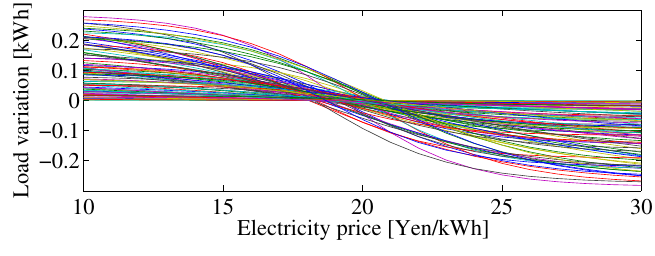
Figure 3. Function of power